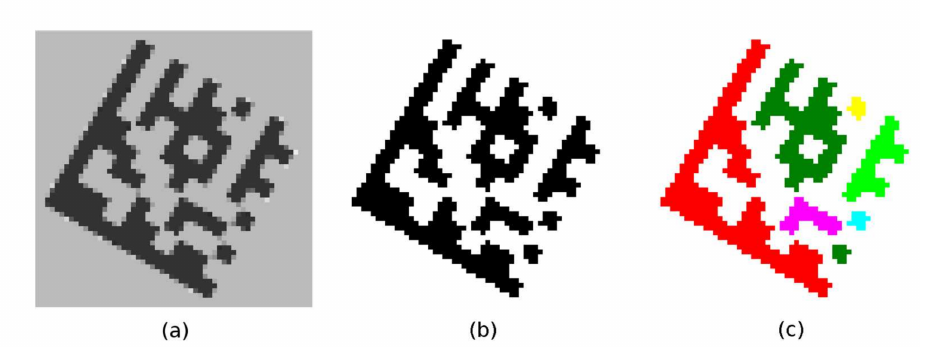
Figure 8. ( a ) grayscale image; ( b ) binarized image; ( c ) colored continuous